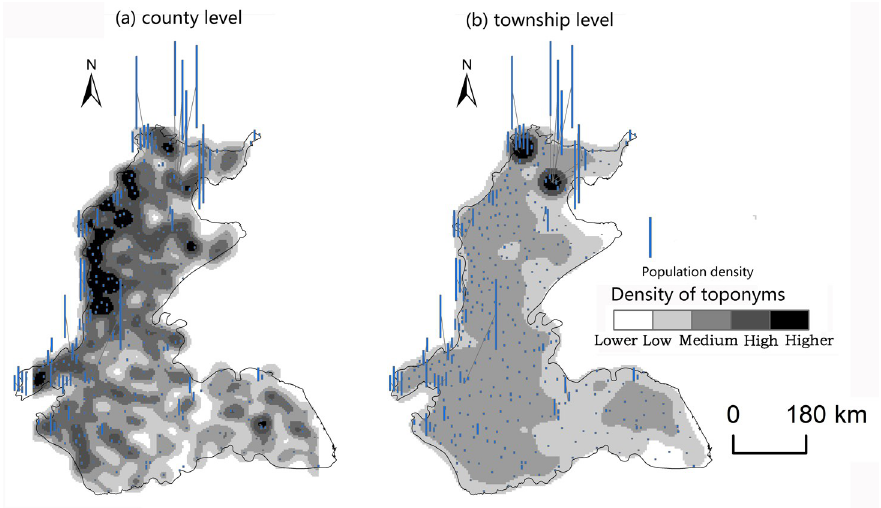
Fig 12. Spatial distribution of toponym density and county population density in the North China Plain.